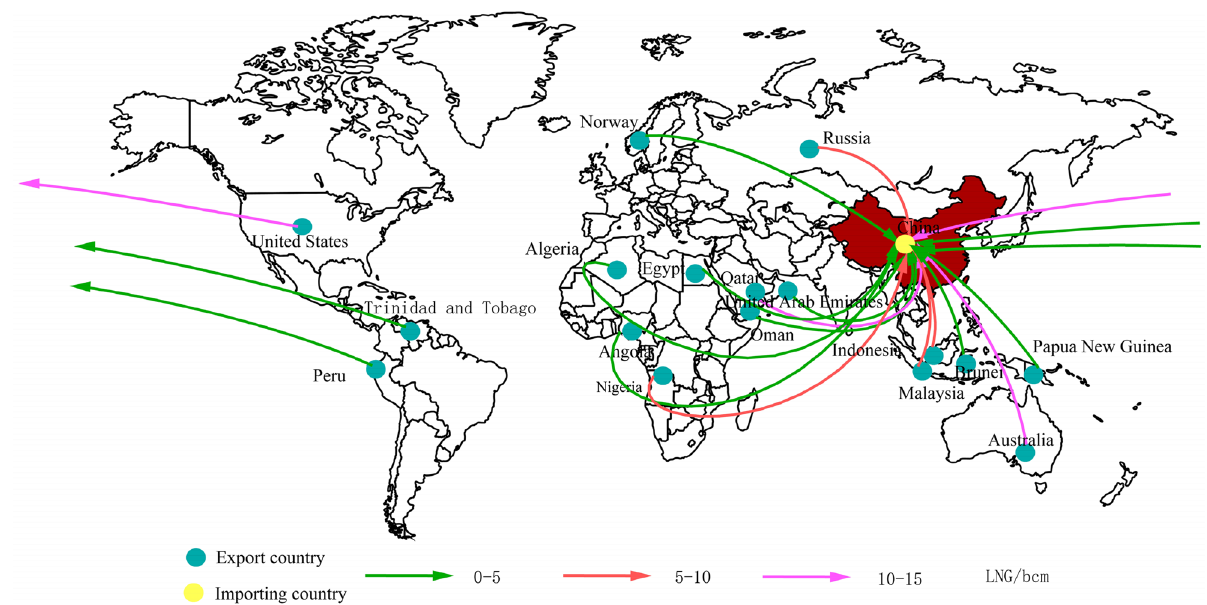
Figure 6. Simulation of China’s LNG import strategy in